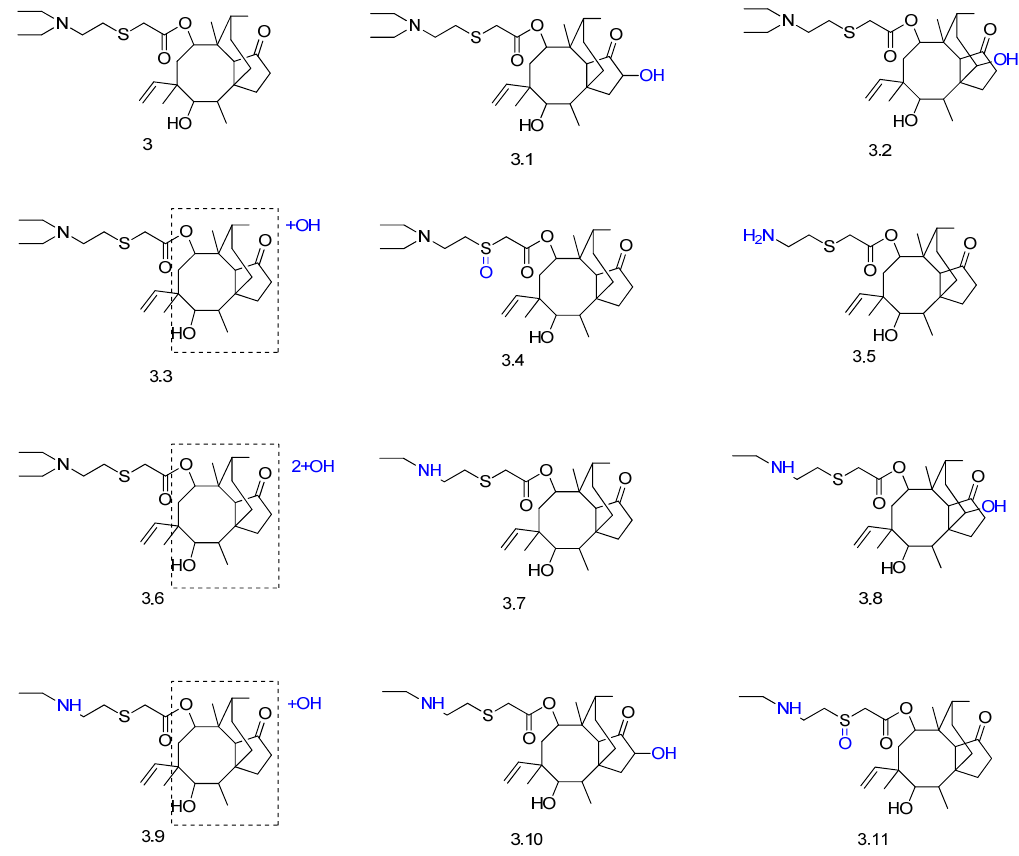
Figure 5. Proposed biotransformation metabolites of tiamulin ( 3 ) obtained in animals in vivo and in rats, swine, chickens, cows and goat liver microsomes [38].